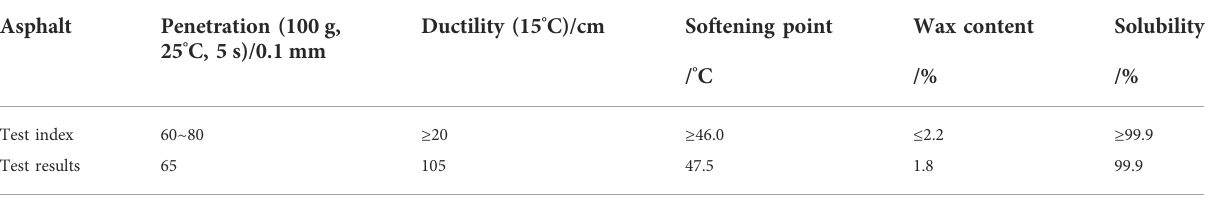
TABLE 3 Properties of the asphalt mixtures.